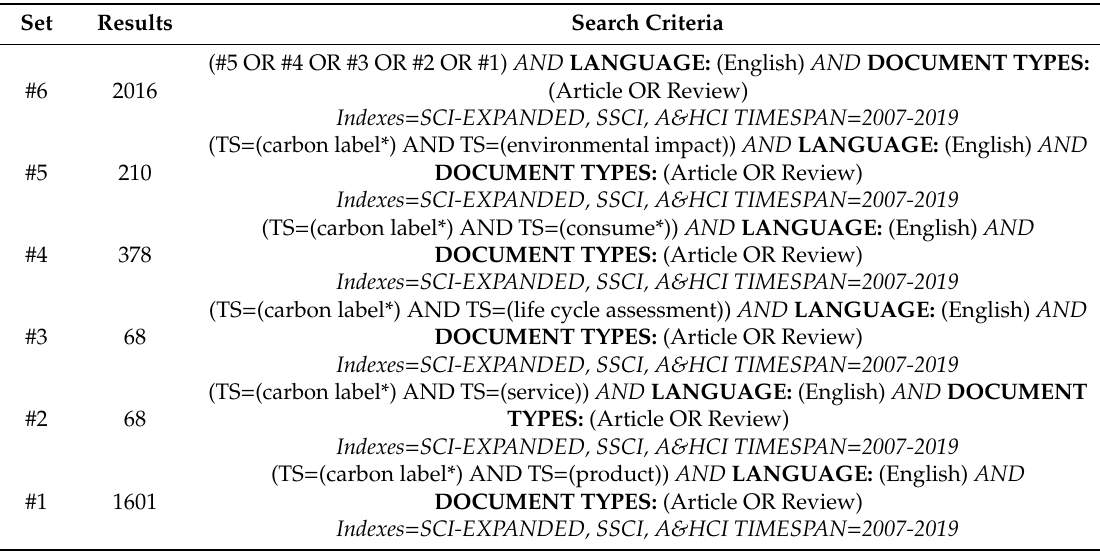
Table 1. Criteria for literature data